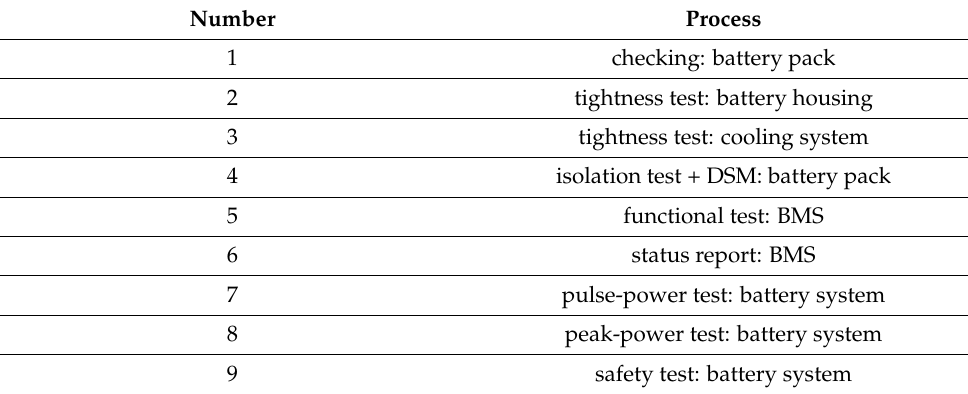
Table A14. Activities of the main application process “reuse”: reuse test (approval of suitability).